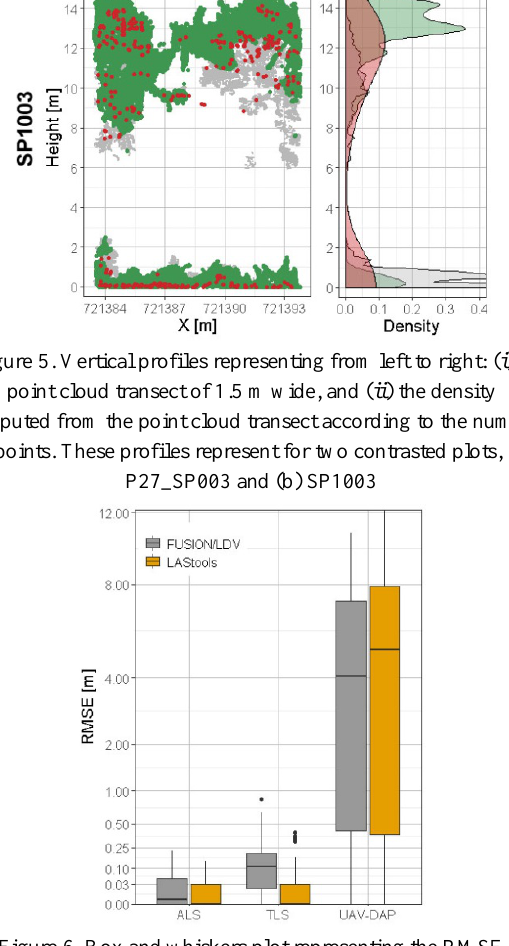
Figure 6. Box and whiskers plot representing the RMSE between the DTMs extracted using ALS, TLS and UAV-DAP, and the reference DTM, using different processing tools (i.e., FUSION/LDV© and LAStools©) and different algorithm parameters differences are increased as shrub cover increases. Differences computed for ALS show that canopy cover and terrain slope have a slight influence, since the differences for the different algorithm and algorithm parameters show less dispersed results as the canopy cover and the terrain slope are sparse and slight, respectively. Nevertheless, differences become more